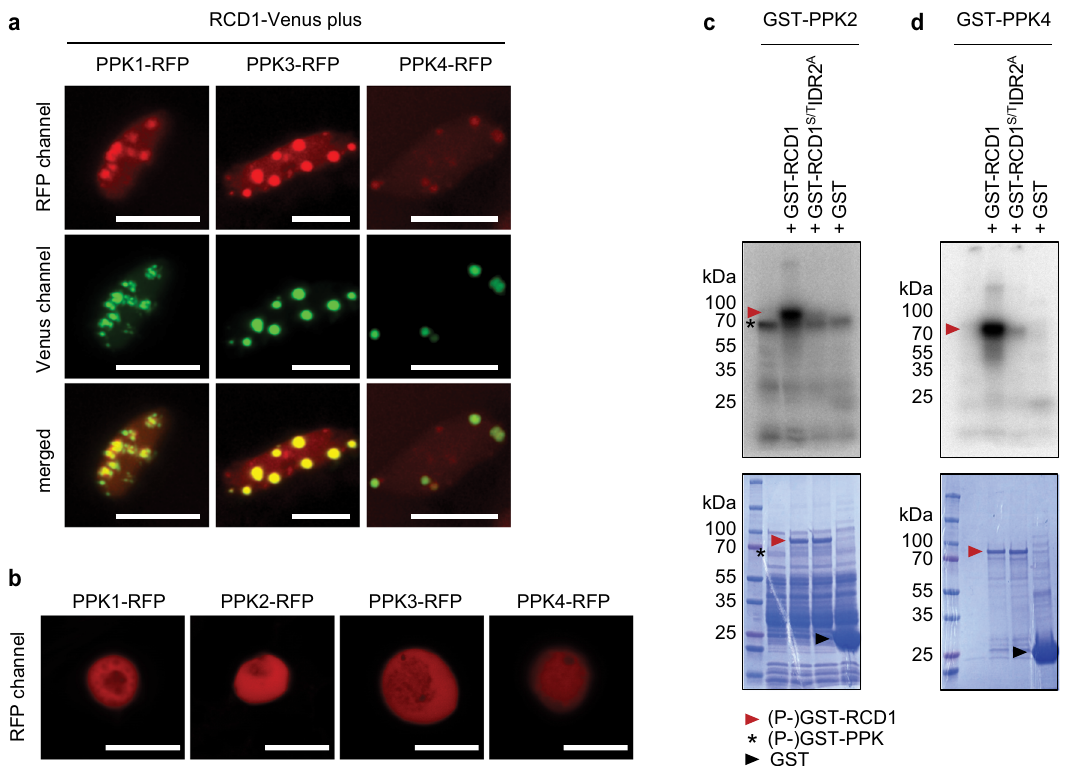
Fig. 3 PPKs co-localize with RCD1 in NBs and directly phosphorylate RCD1 in vitro. a RCD1 co-localizes with PPK1, PPK3 and PPK4 in NBs in Arabidopsis. RFP-tagged PPKs were transiently expressed in Arabidopsis seedlings expressing RCD1-Venus and the subnuclear localization was analyzed by confocal microscopy. Scale bars indicate 10 µ m. b PPK-RFPs alone do not form NBs when transiently expressed in tobacco. PPK-RFP fusion proteins were expressed in tobacco leaves without co-expression of RCD1-Venus. c, d PPK2 and PPK4 directly phosphorylate RCD1. Recombinant GST-PPK2 and GST-PPK4 were used together with recombinant GST-RCD1 and the mutated GST-RCD1 S/T IDR2 A protein in in vitro kinase assays. GST-PPK2 and 4 (asterisks) showed activity towards GST-RCD1 (red arrowhead). Upper panel shows autoradiograph, lower panel shows the Coomassie-stained